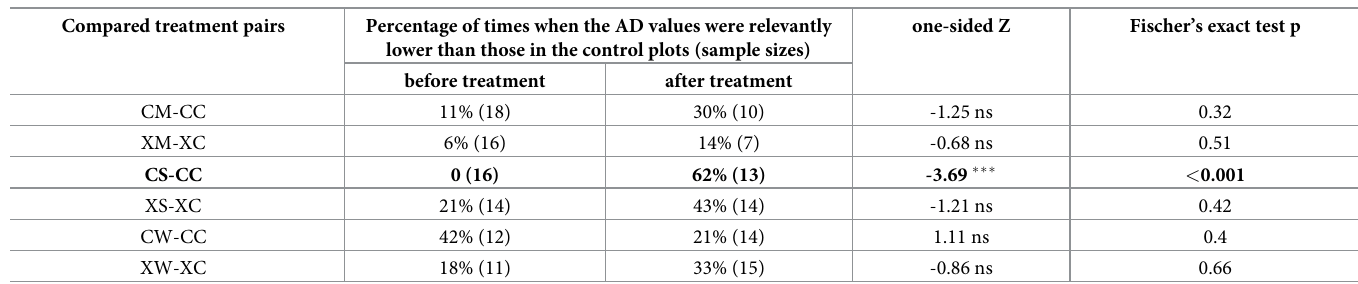
Table 3. Comparison of activity density difference (ADD) proportions. Percentage of times when the AD values were relevantly lower than those in the control plots (sample sizes)